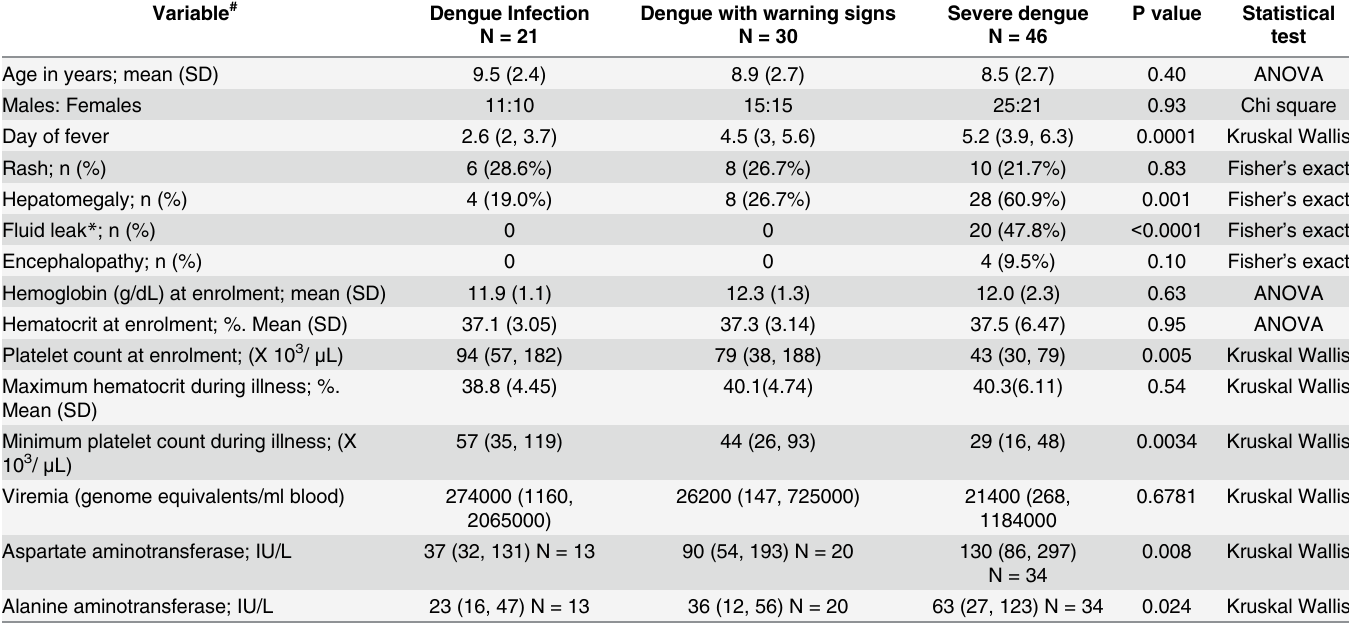
Table 1. Clinical and laboratory data on the day of admission of patients with dengue illness.